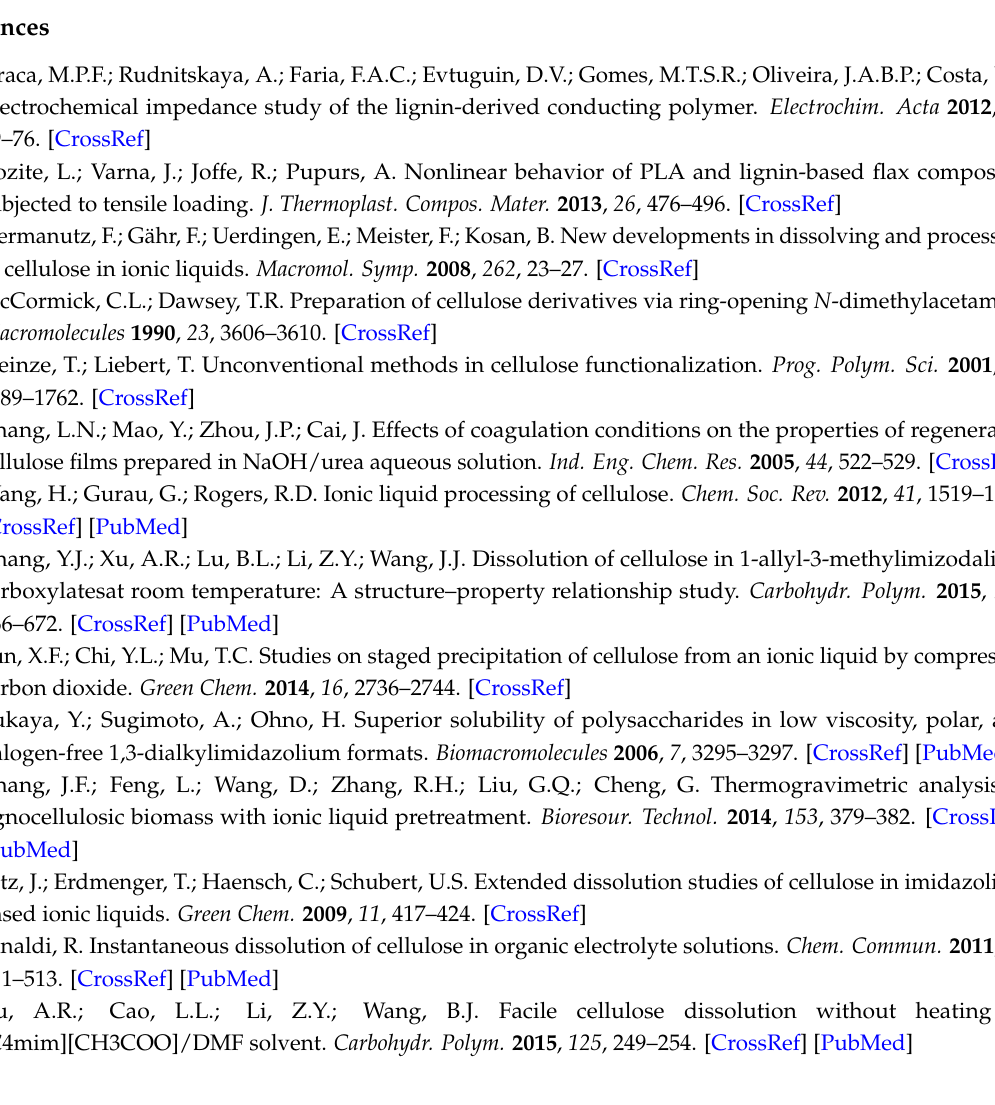
Figure S1: 13 C NMR spectra of [Amim][CH 3 COO] in [Amim][CH 3 COO]/PEG-10 solvent at room temperature, Figure S2: 13 C NMR spectra of [Amim][CH 3 COO] in [Amim][CH 3 COO]/PEG-10/cellulose(8%) solution at room temperature, Figure S3: 13 C NMR spectra of the original [Amim][CH 3 COO]/PEG-10 solvent at room temperature, Figure S4: 13 C NMR spectra of the recovered [Amim][CH 3 COO]/PEG-10 solvent at room